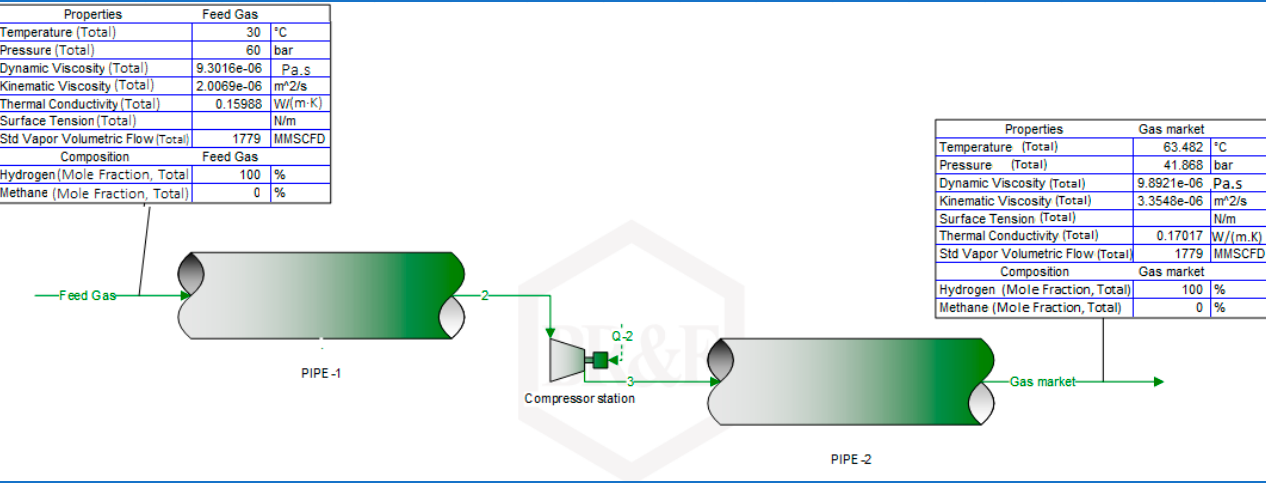
Figure 7. Compressor station option model for 100% hydrogen.